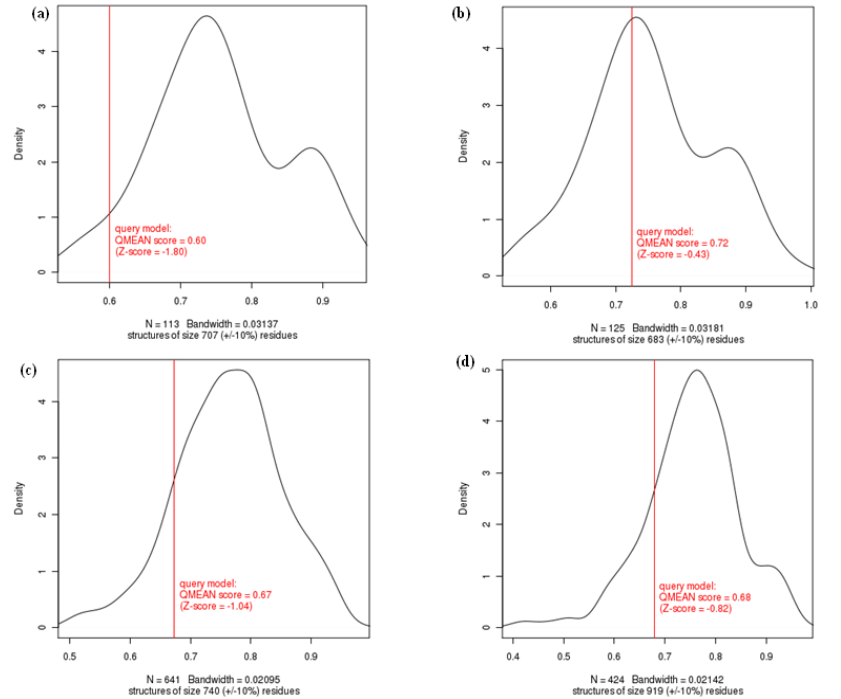
Figure 3. Density plot of predicted models and the template structure (3BOW) provide a measure of quality by relating models to reference structures of similar size solved by